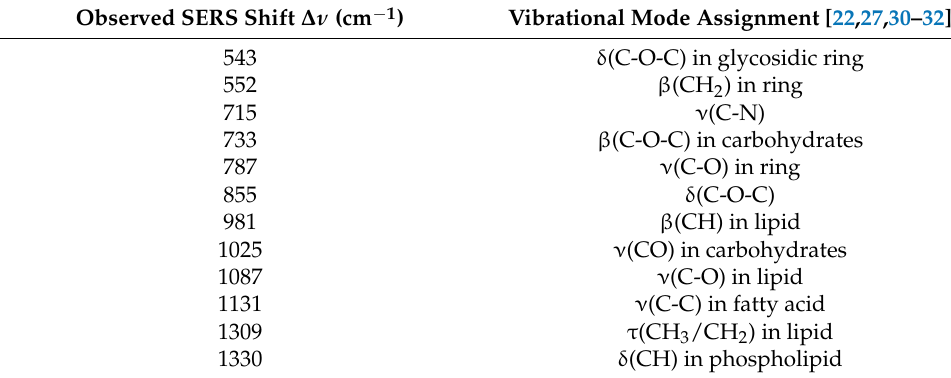
Table 2. SERS peak assignment for enteric LPS